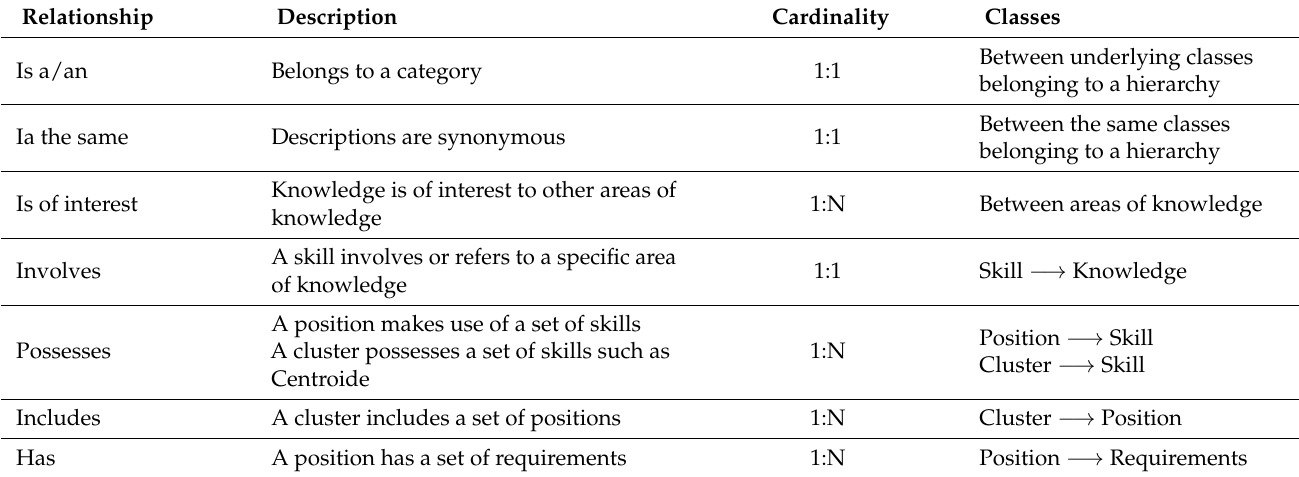
Table 4. Ontology